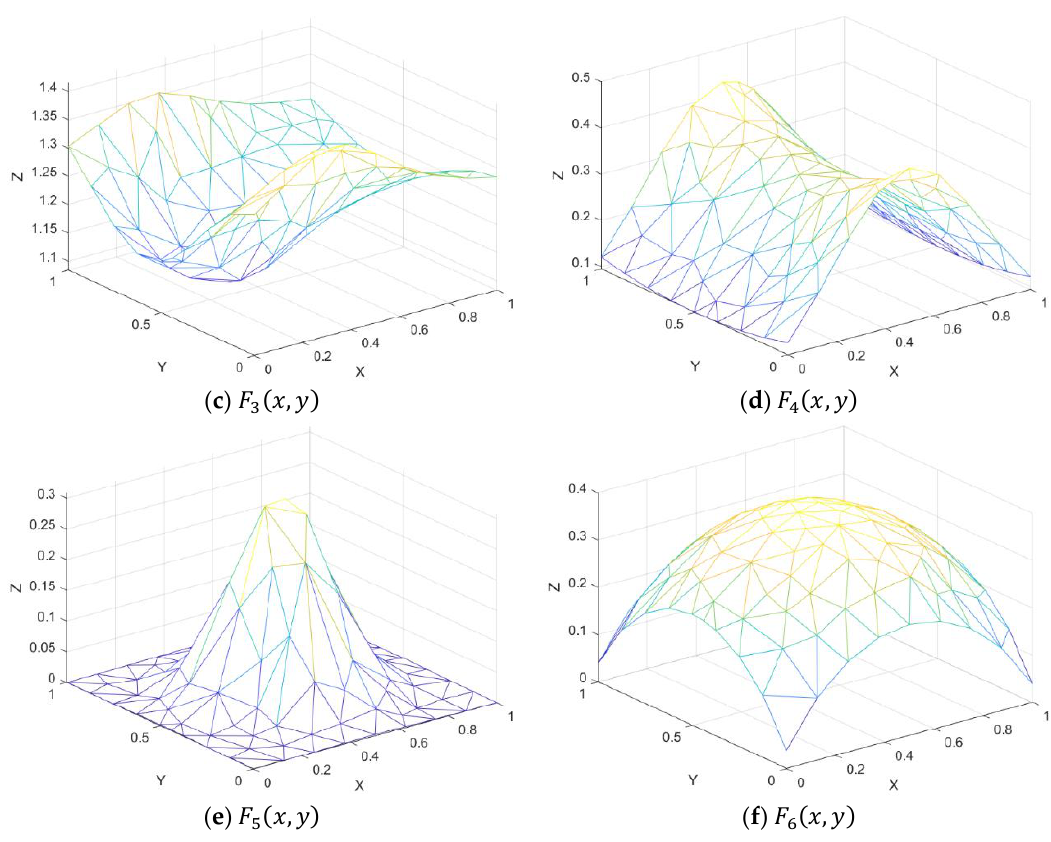
Figure 11. 3D linear interpolant for 100 datasets.